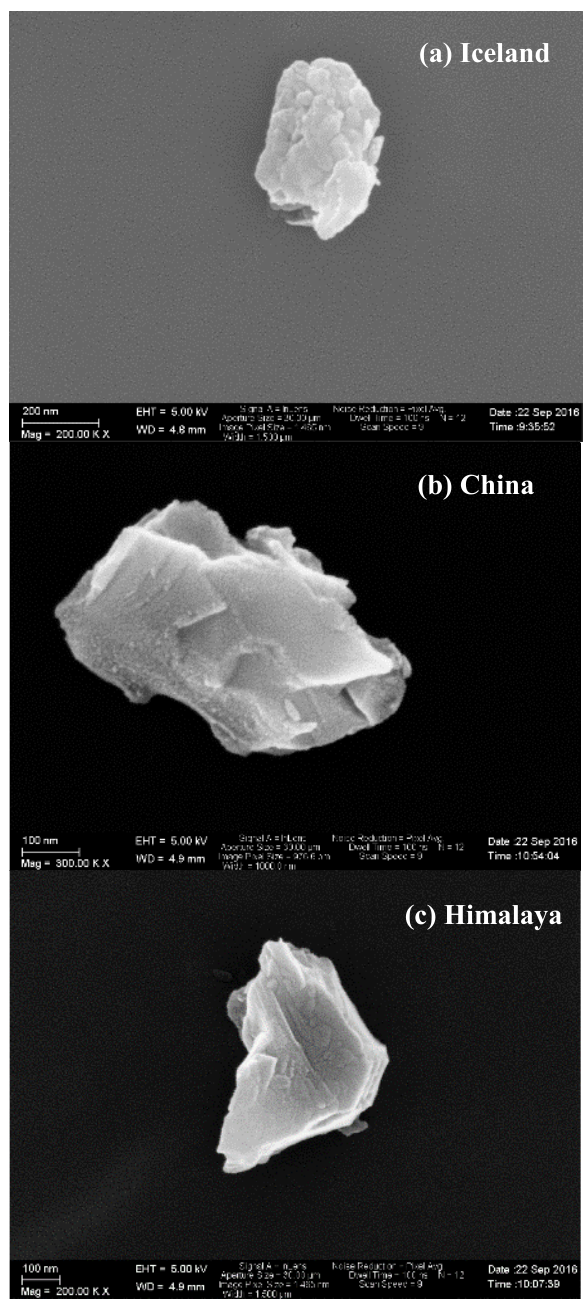
Figure 8. Scanning electron microscopy (SEM) images of the un- treated Iceland (a) , China (b) and Himalaya (c) dust particles. Of all images taken, the images presented here are the most representative of the morphology and